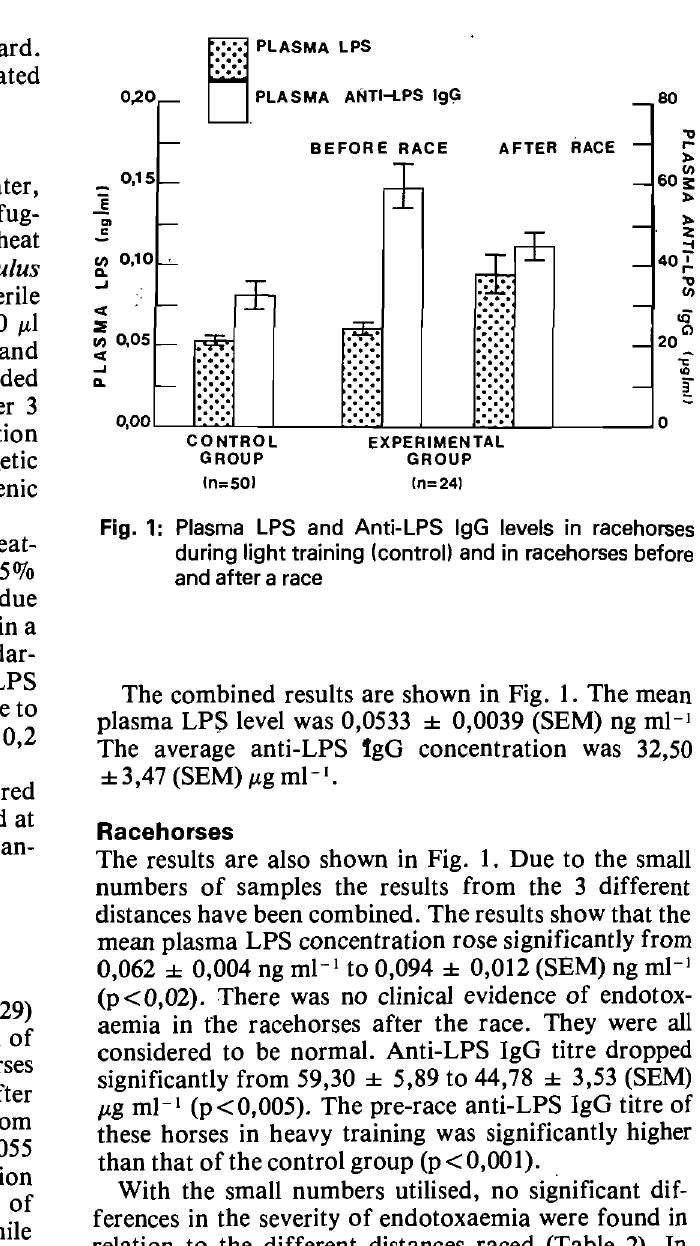
Table 2: Plasma LPS and Anti-LPS IgG levels in racehorses before and after various races (1 000,2000 and 2800 m). Differences between distance raced, plasma LPS and